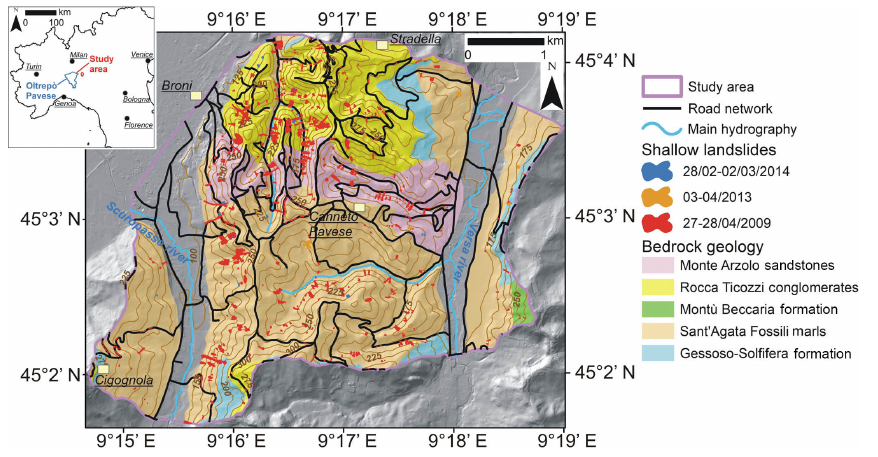
Figure 1. Geological setting and shallow landslide distribution of the study area.